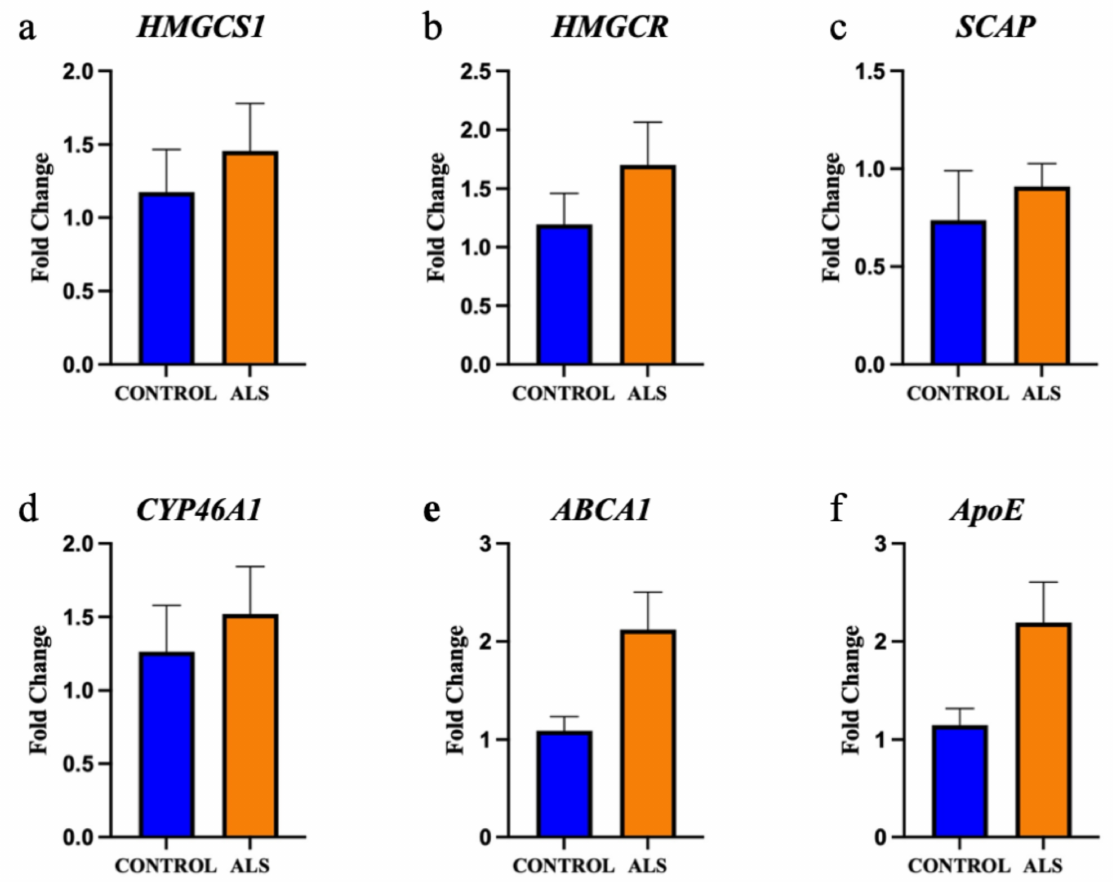
Figure 4. The gene expression of key enzymes involved in cholesterol metabolism are not altered in the motor cortex white matter in ALS. The gene expression of the enzymes: ( a ) hydroxymethylglutaryl- CoA synthase ( HMGCS1 ); ( b ) HMG-CoA reductase ( HMGCR ); ( c ) SREBP cleavage-activating protein ( SCAP ); ( d ) cholesterol 24-hydroxylase ( CYP46A1 ); ( e ) ATP-binding cassette transporter A1 ( ABCA1 ); ( f ) Apolipoprotein E ( ApoE ) are not significantly different in the motor cortex white matter of ALS (sALS n = 8 and fALS n = 6 combined; orange) and control (n = 8; blue)